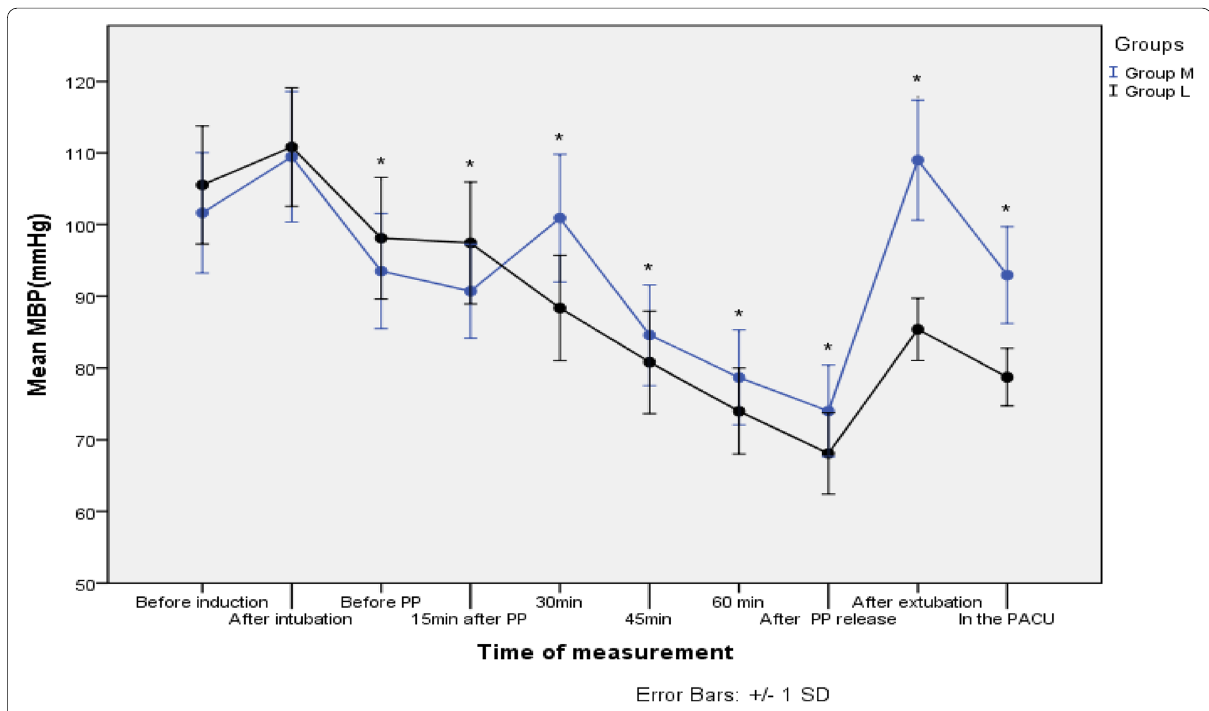
Fig. 3 Mean blood pressure (MBP) at different times of measurements